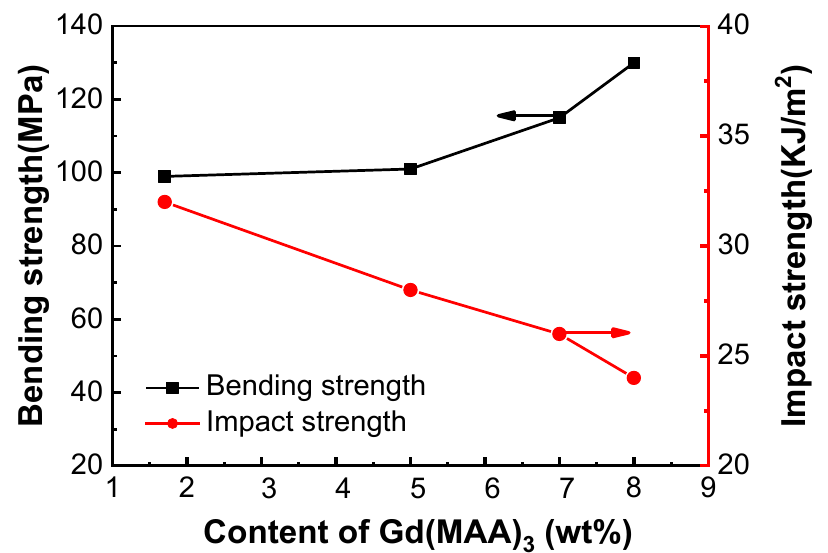
Figure 3. The bending strength and impact strength of metallized acrylic with different Gd(MAA) 3 content.